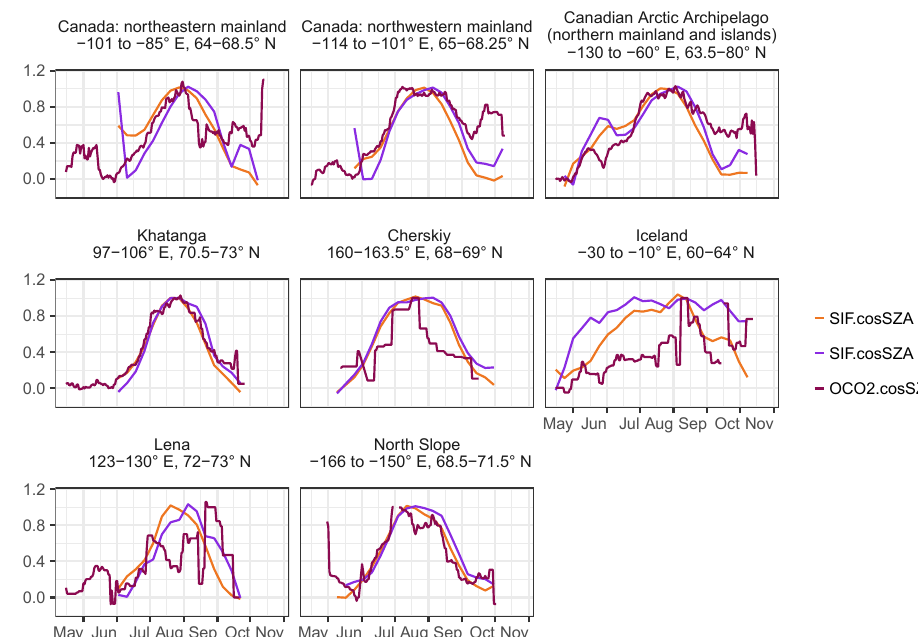
Figure A17. Mean seasonal cycles of SIF data from GOME-2 and OCO-2 as a comparison. Values are scaled to 0 /